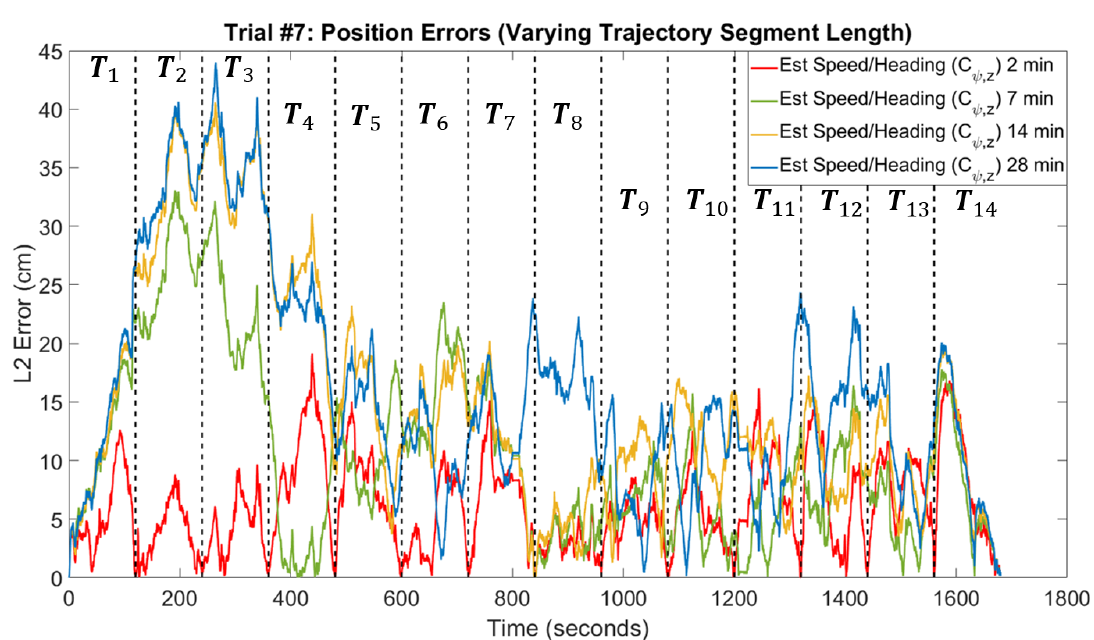
Figure A1. Trial #7 Position Errors (Varying Trajectory Segment Length): Distance between the ground truth and estimated position trajectories for configuration C ψ , z are shown for varying trajectory segment lengths. The T i terms denote the ith trajectory segment for the two-minute